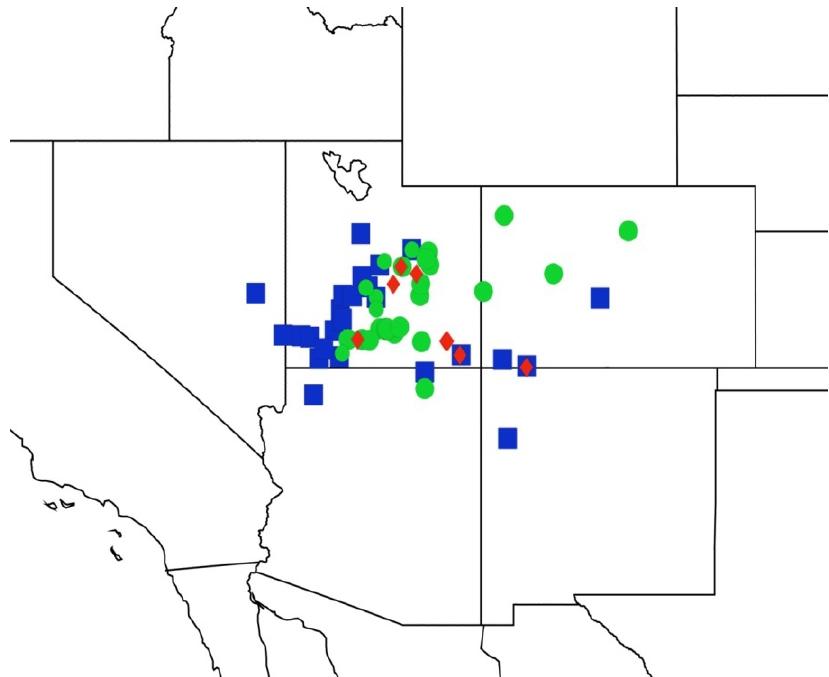
Figure 52. Distribution of Okanagana schaefferi (blue squares), O. tanneri (green circles) and O. sugdeni (red